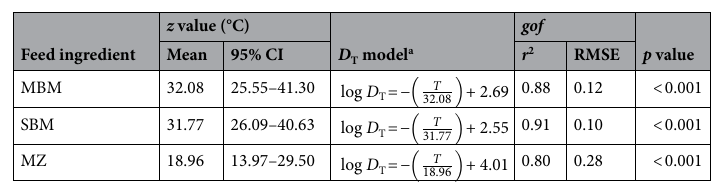
Table 4. Z value and D T model of ASFV in 3 feed ingredients. a log D T (min) for the unknown inactivation temperature T ( ׄ